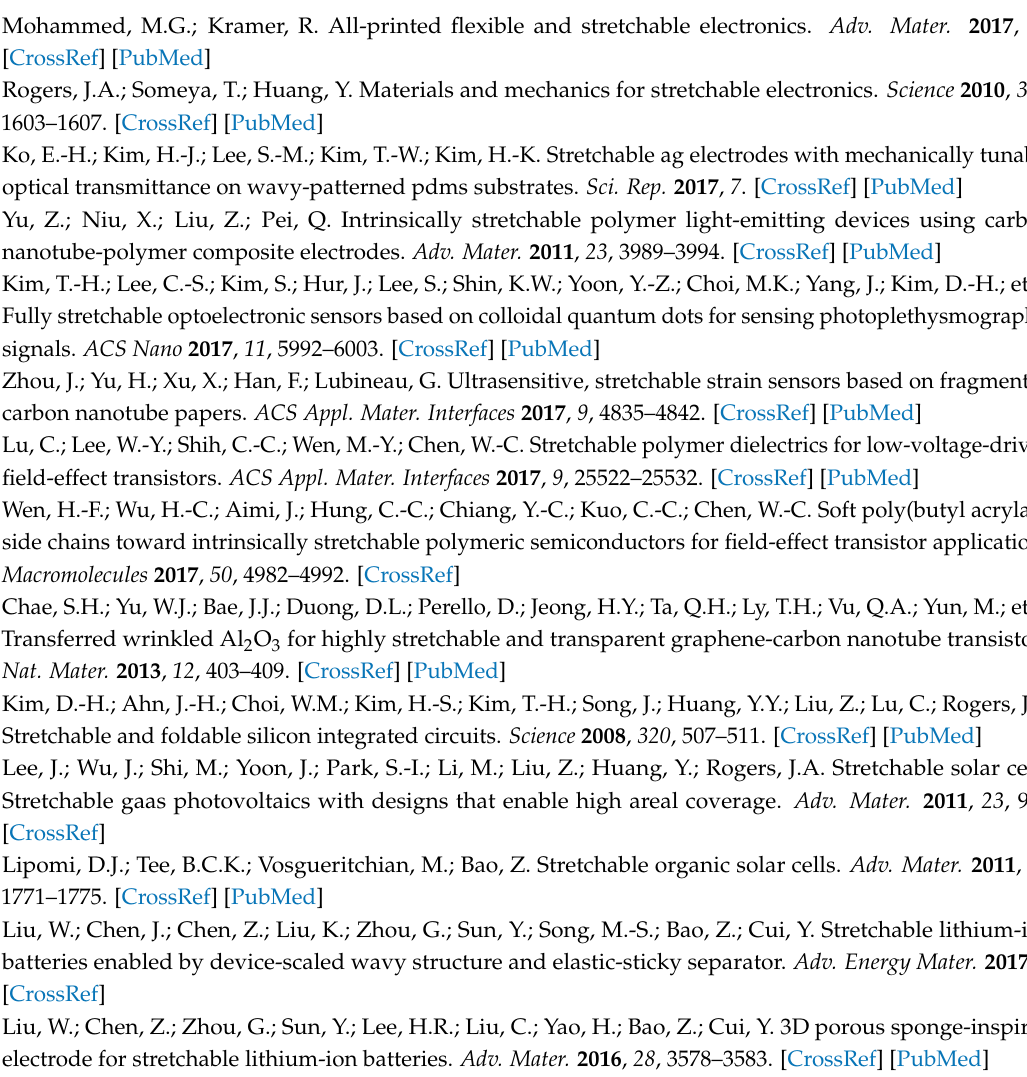
Figure S1: Strain-stress curve for SBS nanofiber film with 1 g, 2 g, and 4 g, Figure S2: FESEM image of SWCNT/SBS nanofiber mat with Zonyl treatment, Figure S3: Micrographs of SBS and SWCNT-SBS nanofibers before/after stretching, Figure S4: Cyclic voltammograms of supercapacitors at the scan rate from 0.005 to 0.1 V s − 1 upon (a) 20%, and (b) 40% strain, title, Table S1: Comparison of the electrochemical performances for various stretchable supercapacitors from the previous researches with our